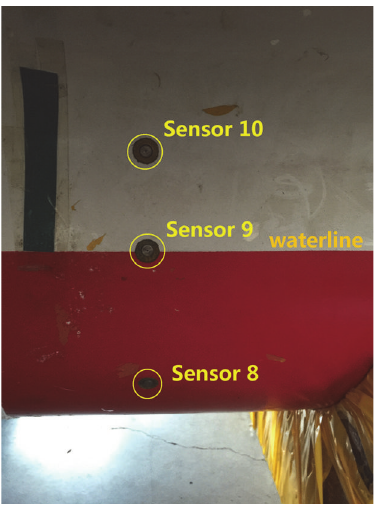
Figure 9: Irregular waves time histories.